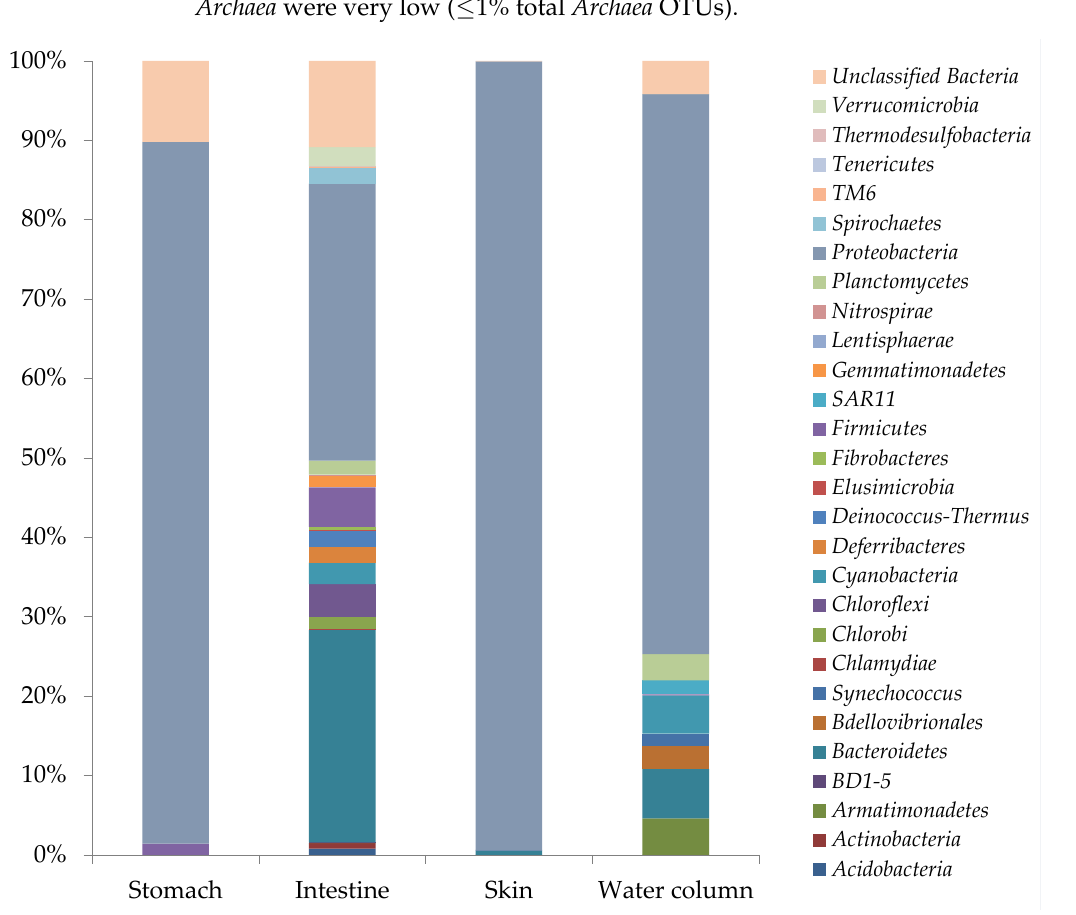
Figure 2. Relative abundance of sequences (percentage) assigned to Bacteria and Archaea domains phylogenetic groups from skin, stomach, and intestine of D. eleginoides.